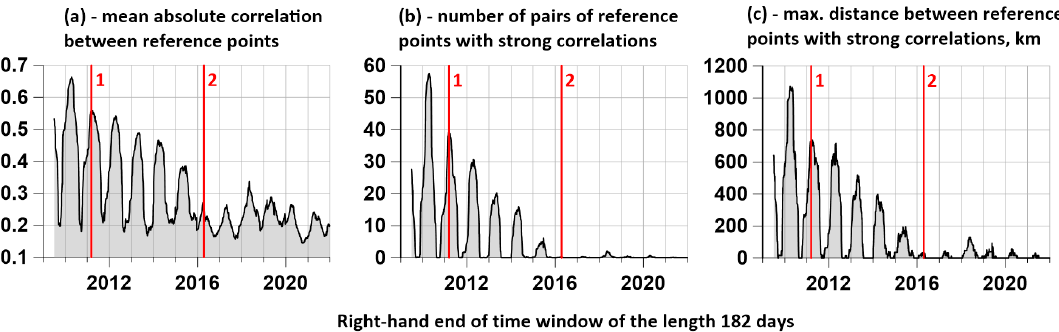
Dependences (10) are shown in Figure 7. Quantities (10) could be called measures of the activity of the Earth’s surface tremor.